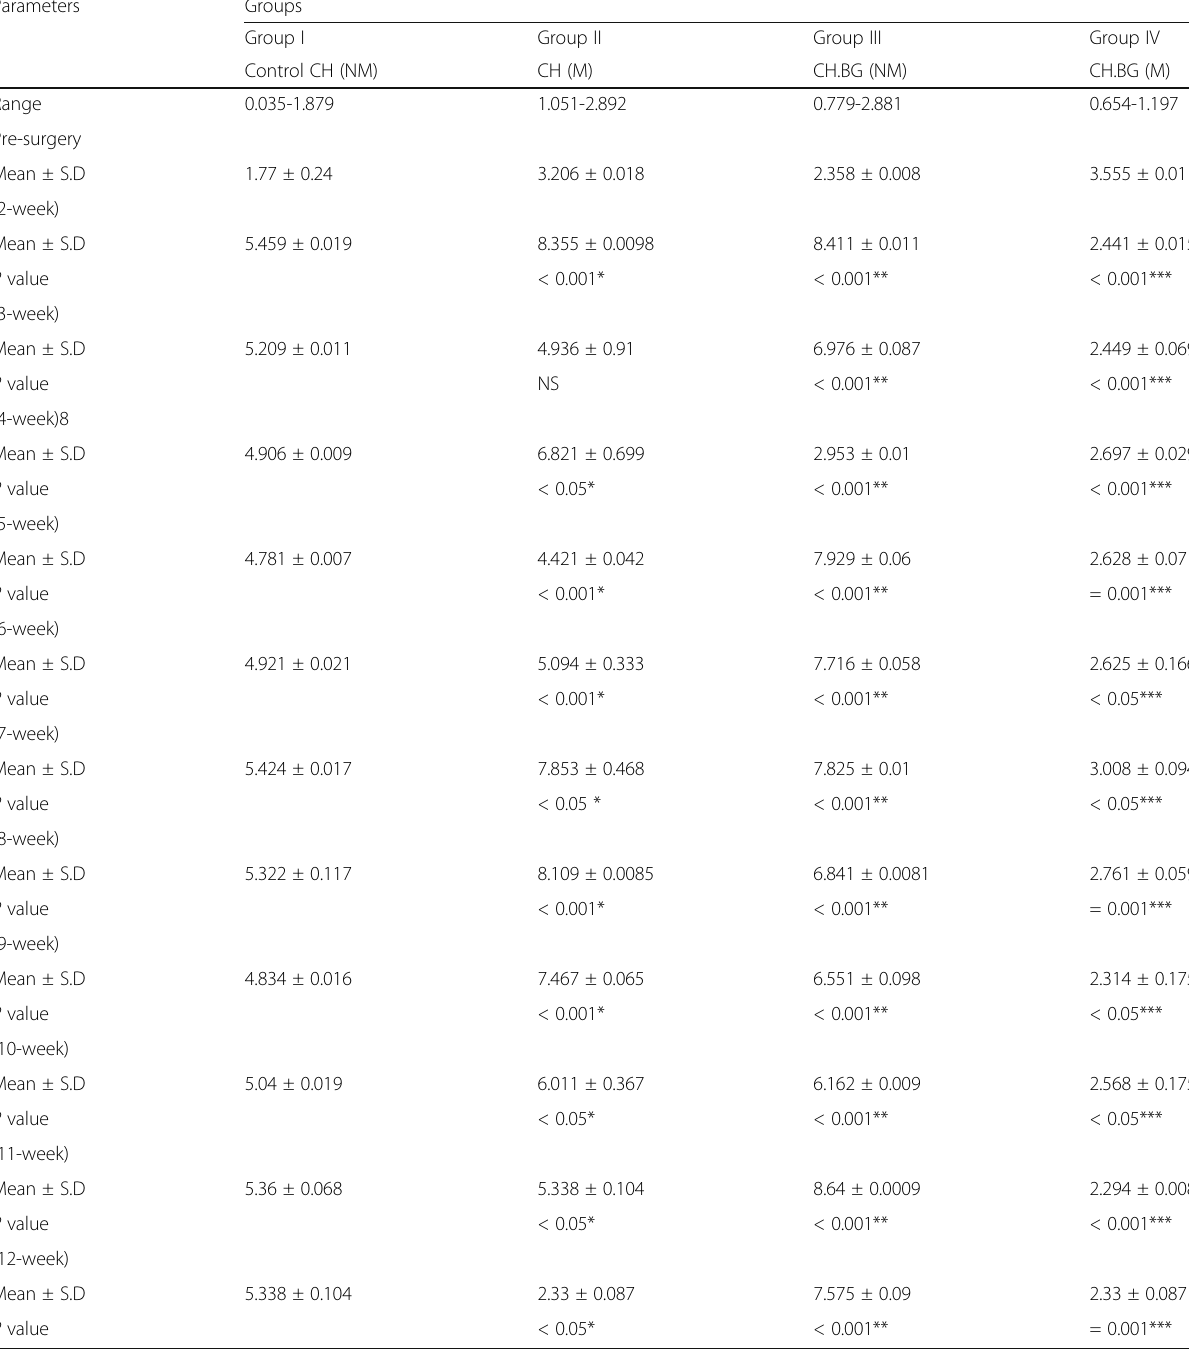
Table 2 Serum BMP-2 (ng/L) activity among the studied